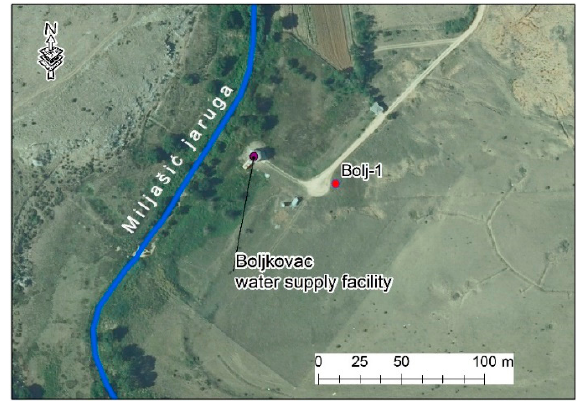
Figure 5. Boljkovac water supply facility, Miljaši ć Jaruga watercourse, and piezometric borehole BOLJ-1 [27].